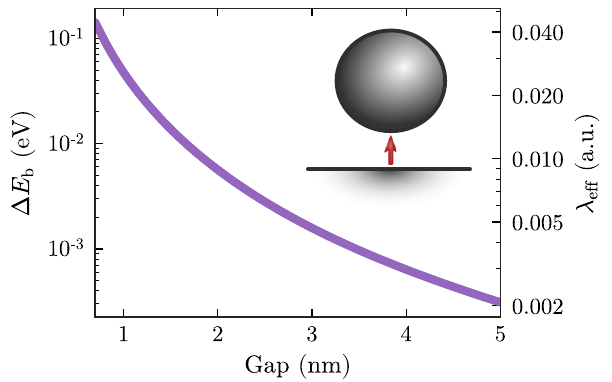
FIG. 5. Change of the energy barrier for the Shin-Metiu model inside a nanoparticle-on-mirror cavity as a function of the gap size. The right y axis shows the corresponding values of the effective single-molecule coupling strength λ set: Illustration of nanoparticle-on-mirror cavity geometry, with a single molecule placed in the nanogap between a planar metallic surface and a small metallic nanoparticle of radius R ¼ 20